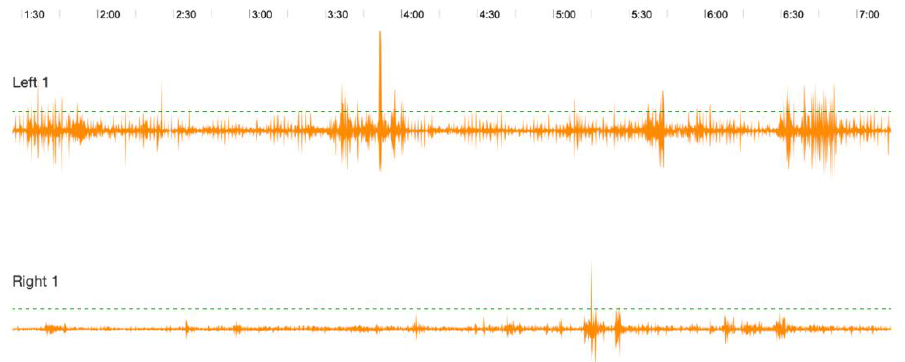
Figure 4. Rumen sound recordings made from a CURO MkII simultaneously from a lactating (Cow #2; Left 1) and a dry cow (Cow #3; Right 1), showing the increased amplitude and frequency of rumen sounds in the lactating cow. Recordings were taken from animals from Assendrup Hovedgård (Haslev, Denmark). The sound recording in the lower panel Cow #3 is very similar in amplitude and frequency to those sounds recorded for Cow #1 (Figure 1). The number scale at the top represents time in minutes.